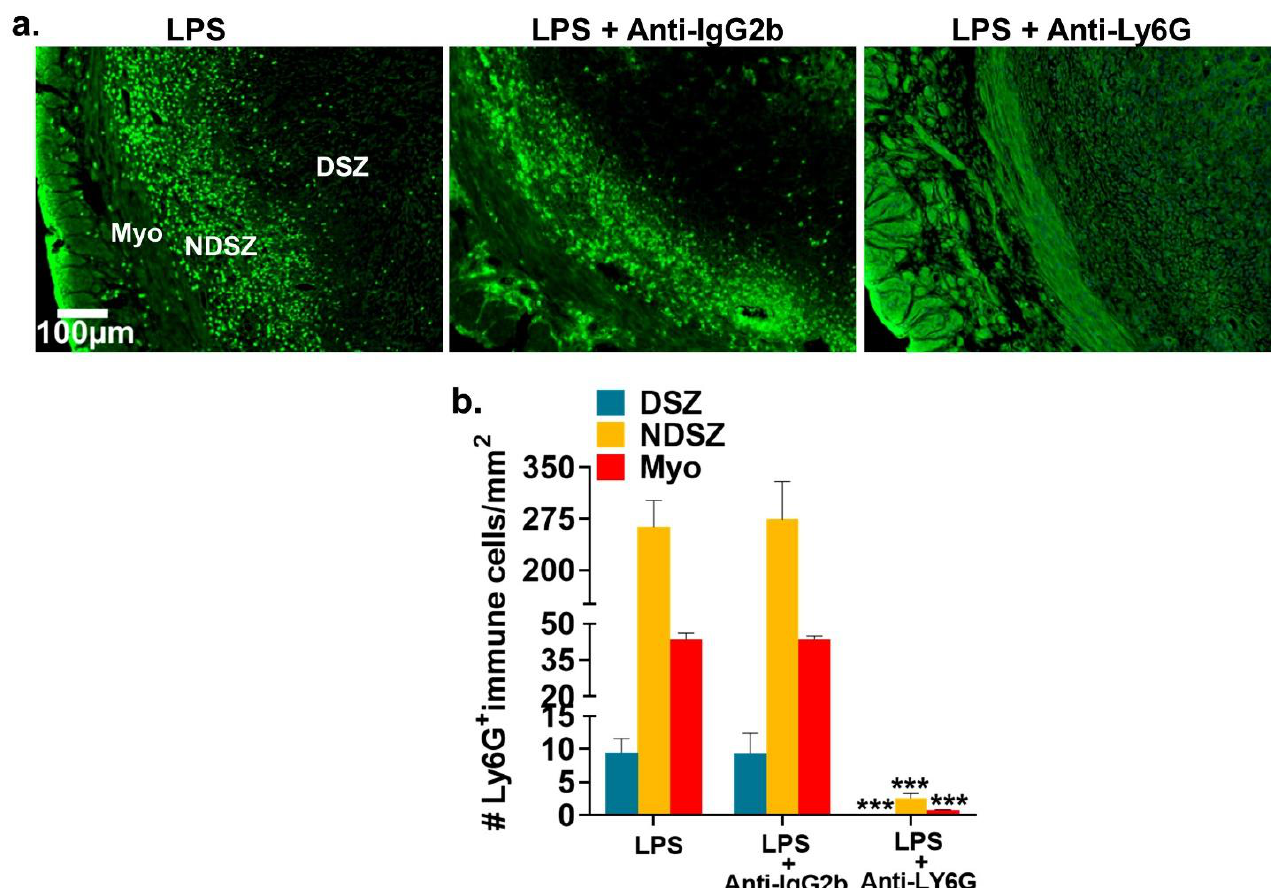
Figure 9. LPS-induced neutrophil recruitment at the EBIS (Day 6) is blocked by prior anti-Ly6G antibody treatment. Anti-Ly6G and anti-IgG2b antibodies (150 µg/mouse) were injected (i.p.) on day 4 of pregnancy prior to LPS (1µg/mouse) injection on day 5 of pregnancy. BISs were excised 24 h after LPS (day 6 of pregnancy). Neutrophils were identified in cross sections of the BIS using NP-specific anti-Ly6G antibodies. At least five pregnant mice were used for each treatment. Cross sections obtained from two pieces of uterine tissues/mouse/dose of day 6 of BIS were fixed, immunostained with anti-Ly6G (green), counterstained with DAPI (blue), photographed and counted. ( a ) Representative immunofluorescence images of EBISs from LPS, LPS plus anti-IgG2b and LPS plus anti-Ly6G treatment groups. Neutrophils were stained with Ly6G antibody. DSZ, decidualized stromal zone; Myo, myometrium; NDSZ, non-decidualized stromal zone; ( b ) Quantification of immune cells at the EBIS from LPS, LPS plus anti-IgG2b and LPS plus anti-Ly6G treatment groups. Total number of Ly6G + cells were counted in three compartments (DSZ, NDSZ and Myo) of the EBIS. At least three immunostained sections from each treatment group were used for immune cell counting. Results are shown as number of Ly6G cells per mm 2 area and represent the mean ±SD. *** p < 0.001 (ANOVA followed by Tukey test).